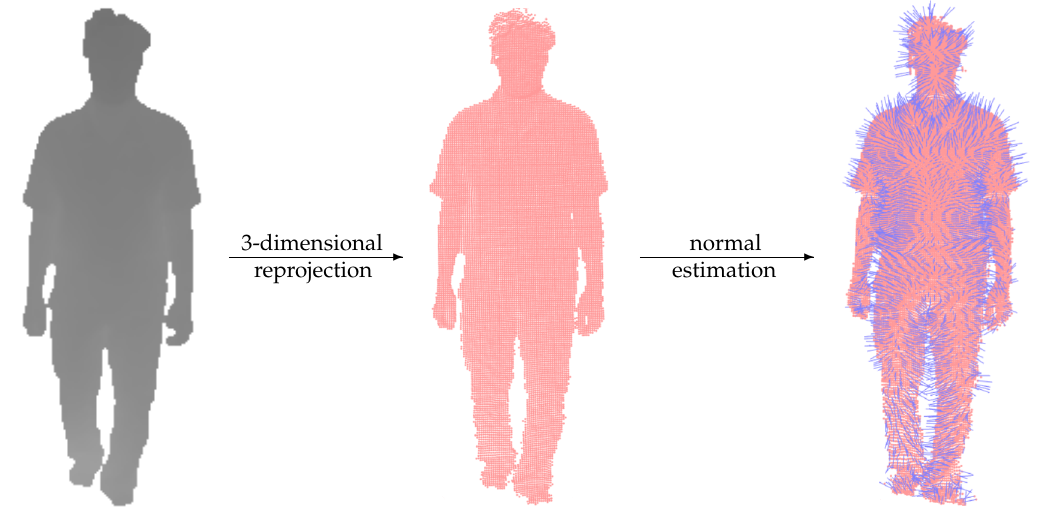
Figure 2. The normal cloud estimated from a depth map via a 3D reprojection. All normal vectors must point to the camera (i.e., non-positive z -coordinate) as a postprocessing of determined